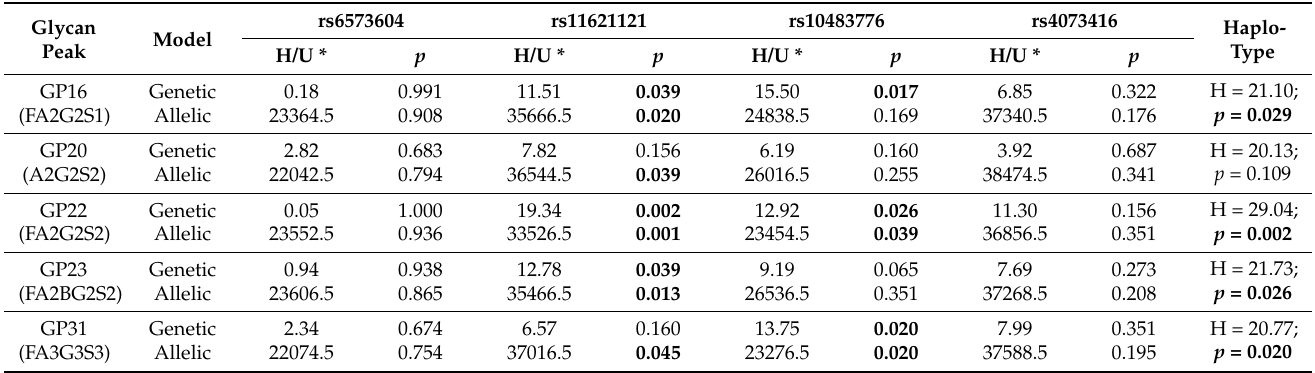
Table 5. Significant associations of the individual rs6573604, rs11621121, rs10483776, and rs4073416 polymorphisms (genetic and allelic model) as well as the rs11621121–rs10483776 haplotypes with the plasma N-glycan levels in the PTSD